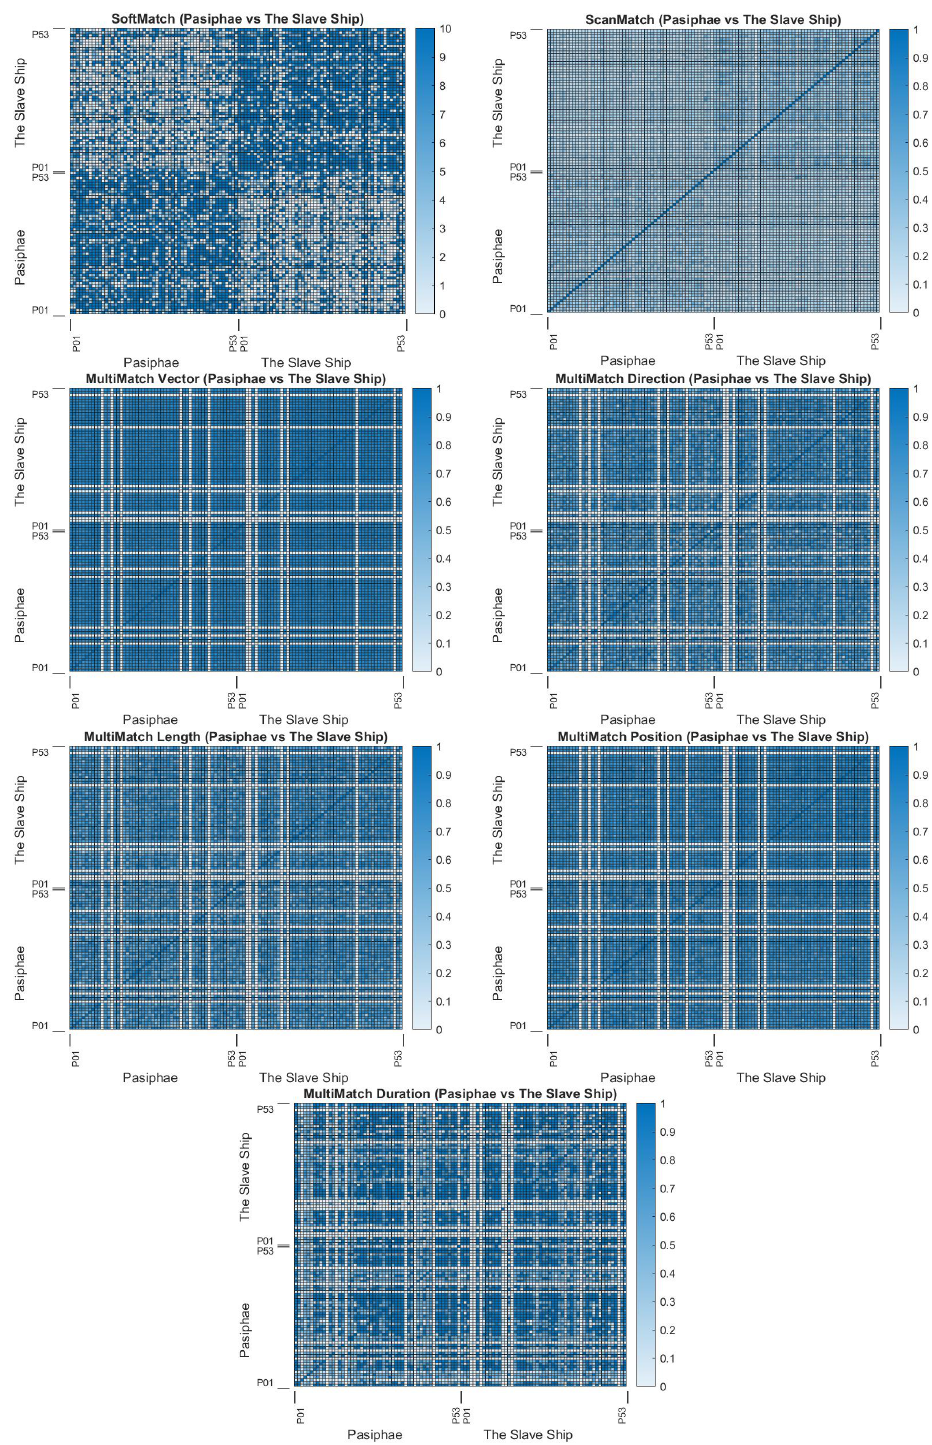
Figure A14. SoftMatch, ScanMatch, and MultiMatch heatmaps for empirical evaluation. Stimuli matched are Jackson Pollock’s Pasiphae (1943) and William Turner’s Starry Night